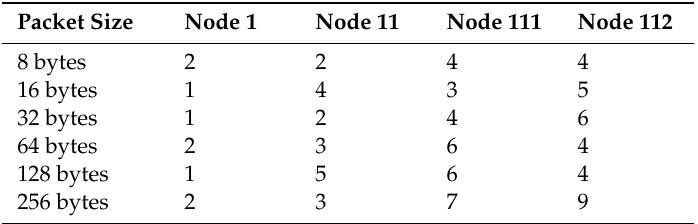
Table 2. Packet loss per node at di ff erent packet sizes.